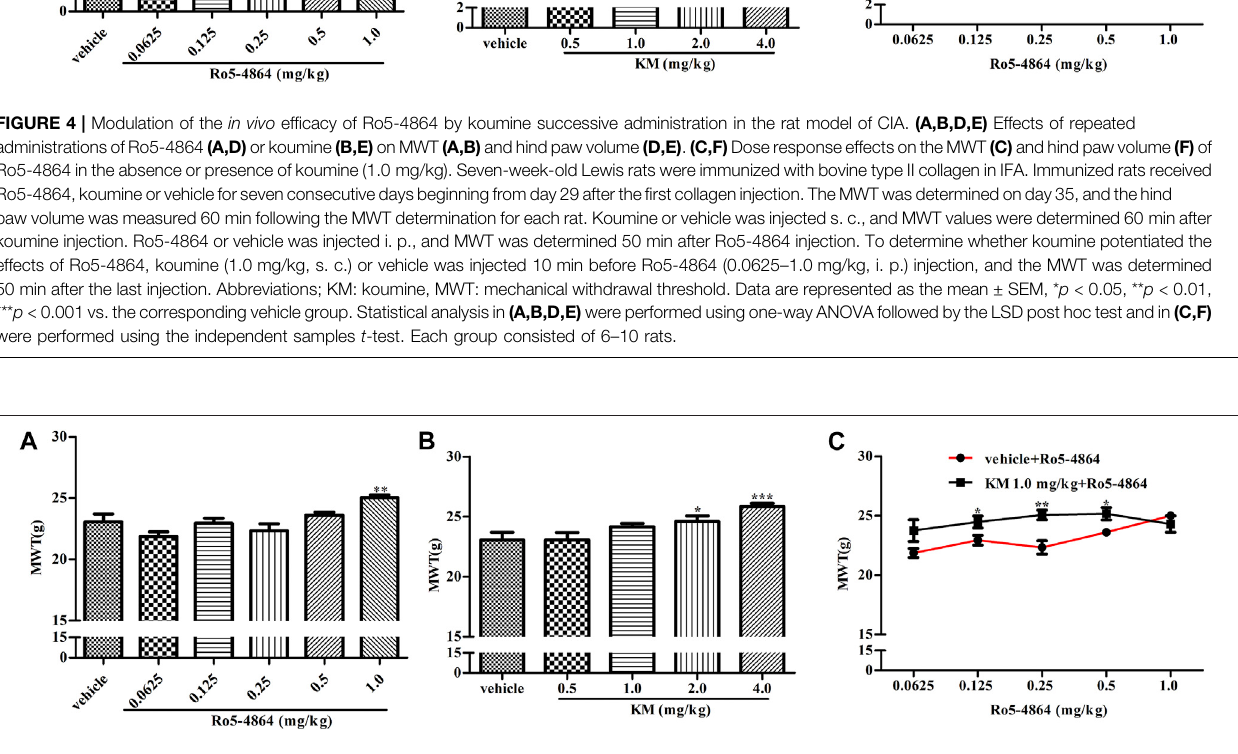
Frontiers in Pharmacology |